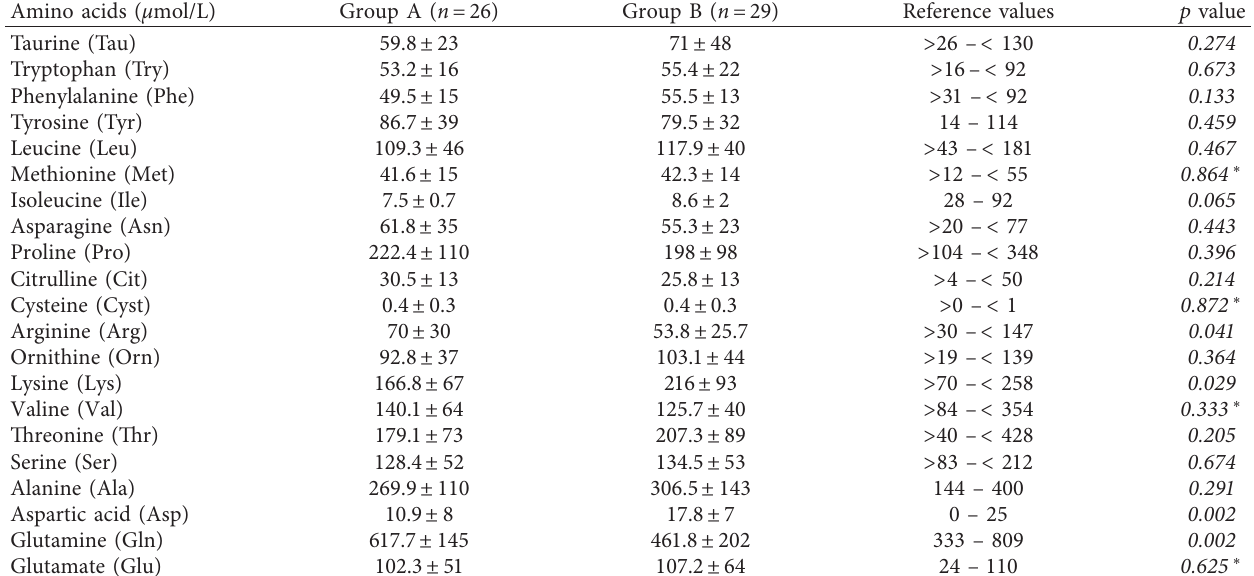
Table 2: The analysis of serum amino acid levels and p values in both